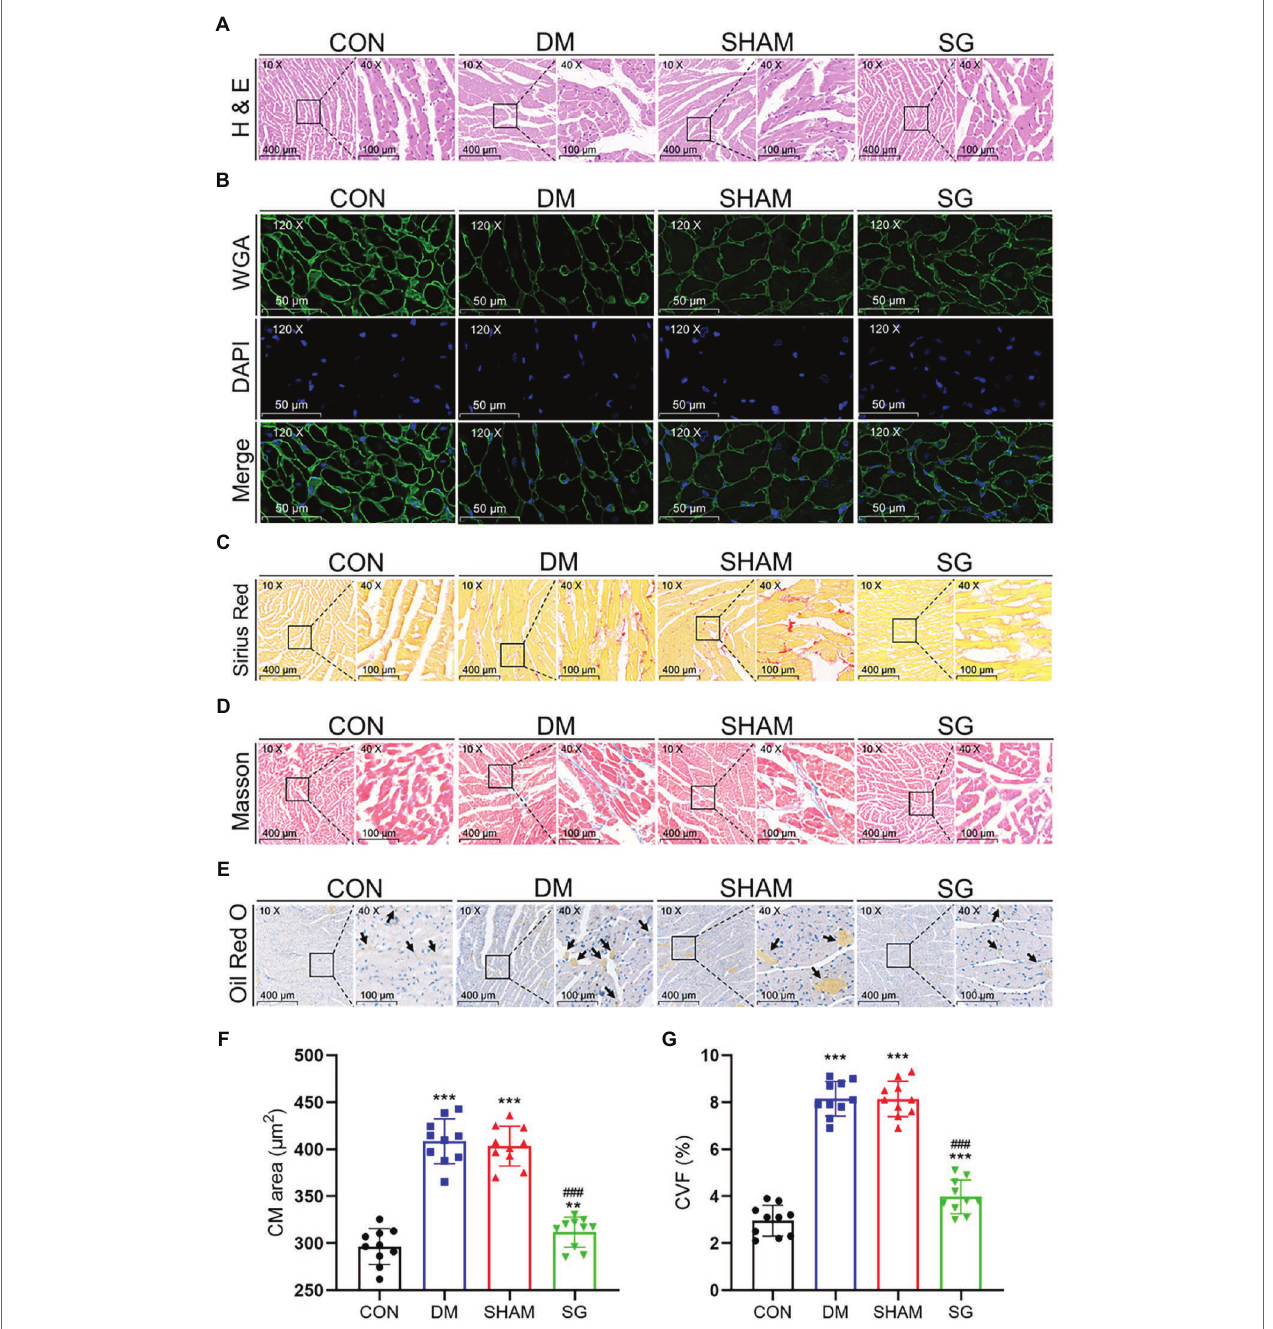
FIGURE 5 | The reversal effect of SG on the heart morphometric and histological. The representative (A) H&E, (B) WGA, (C) Sirius Red, and (D) Masson stainings of heart tissue. (E) The Oil Red O staining of heart tissue, and arrows show lipid droplets (magnification 10×, scale bars represent 400 μ m; magnification 40×, scale bars represent 100 μ m; magnification 120×, scale bars represent 50 μ m). The (F) CM area and (G) CVF were calculated and analyzed. Data are expressed as means ± SEM for n = 10 per groups. * p < 0.05 vs. CON group, ** p < 0.001 vs. CON group, *** p < 0.0001 vs. CON group; # p < 0.05 vs. SHAM group, ## p < 0.001 vs. SHAM group, ###p < 0.0001 vs. SHAM group. H&E, hematoxylin and eosin; WGA, wheat germ agglutinin; CM, cardiac myocyte; CVF, collagen volume fraction; CON, control; DM, diabetes mellitus; SHAM, sham operation; SG, sleeve